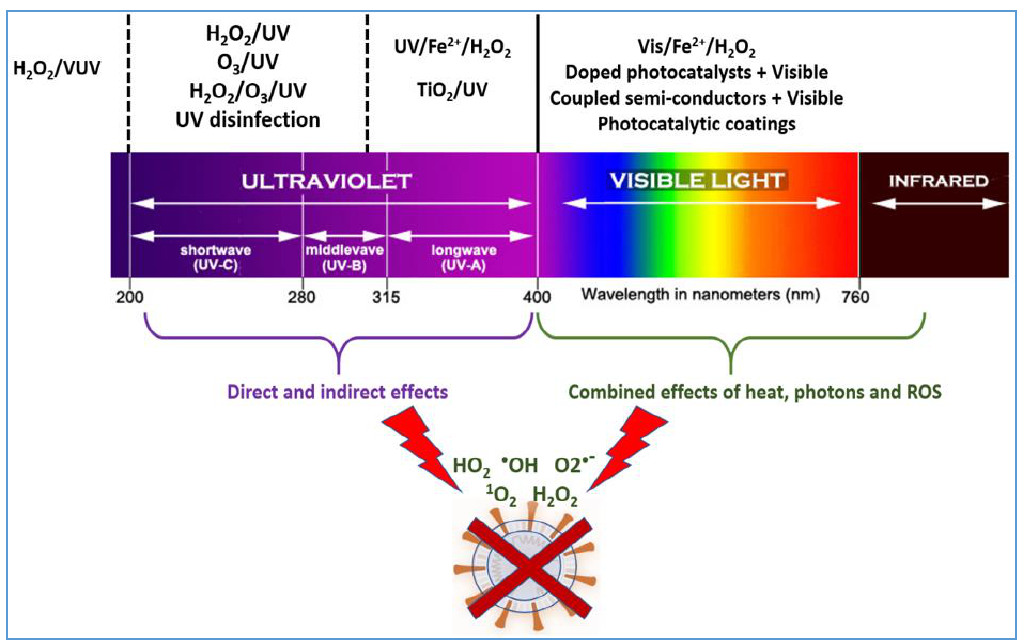
Figure 2. Range of the applied light effective in viral/bacterial inactivation in semiconductors and semiconductors doped by metals or oxides. Decorated, doped semiconductors present interfacial charge transfer (IFCT) processes under solar/visible light.